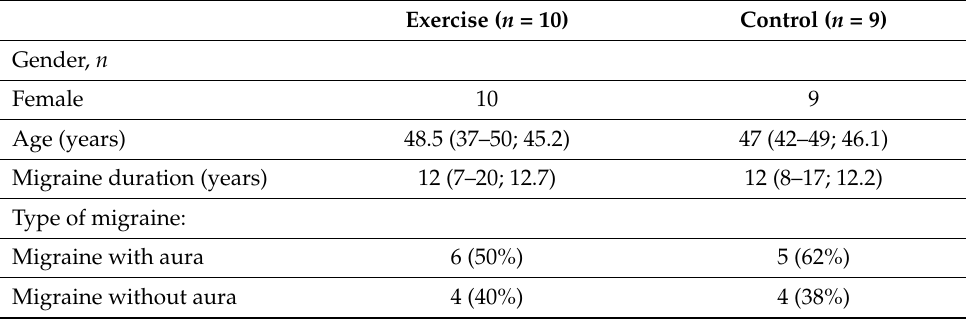
Table 1. Clinical characteristics of persons with